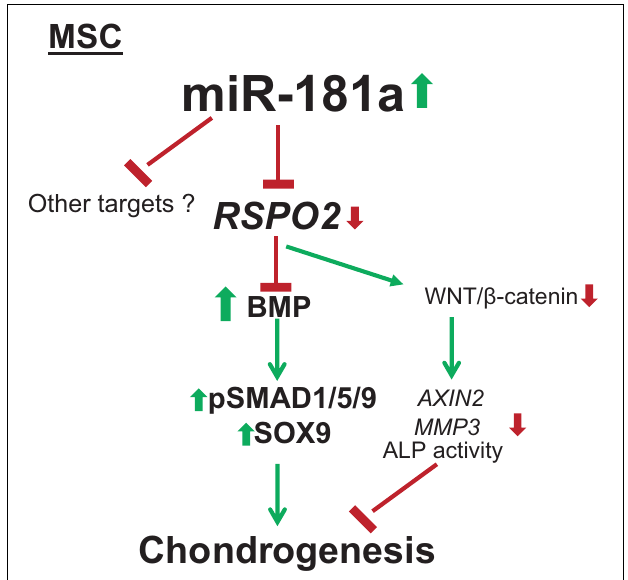
FIGURE 7 | Mechanism for the pro-chondrogenic effects caused by miR-181a. MiR-181a targets RSPO2 which is a strong agonist of canonical WNT signaling and an inhibitor of BMP signaling. Loss of RSPO2 results in activation of BMP signaling manifested by increased phospho-SMAD1/5/9 and SOX9 accumulation, as well as in inhibition of canonical WNT target gene expression, AXIN2, thus, affecting the balance between WNT and BMP signaling to favor chondral outcome. Thin arrows indicate regulations of the highlighted pathways, and thick arrows display the effects caused by miR-181a; red, downregulation; green,